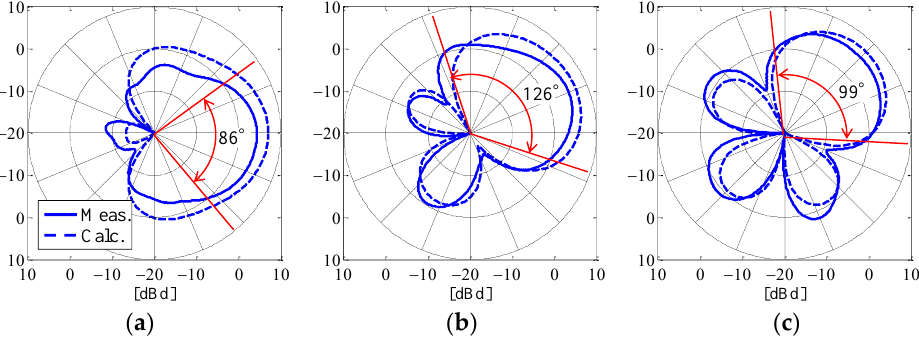
Figure 17. Measurement results for the radiation beam depending on the desired angle: ( a ) ϕ = 0°; ( b ) ϕ = 22.5°; and ( c ) ϕ = 45°.